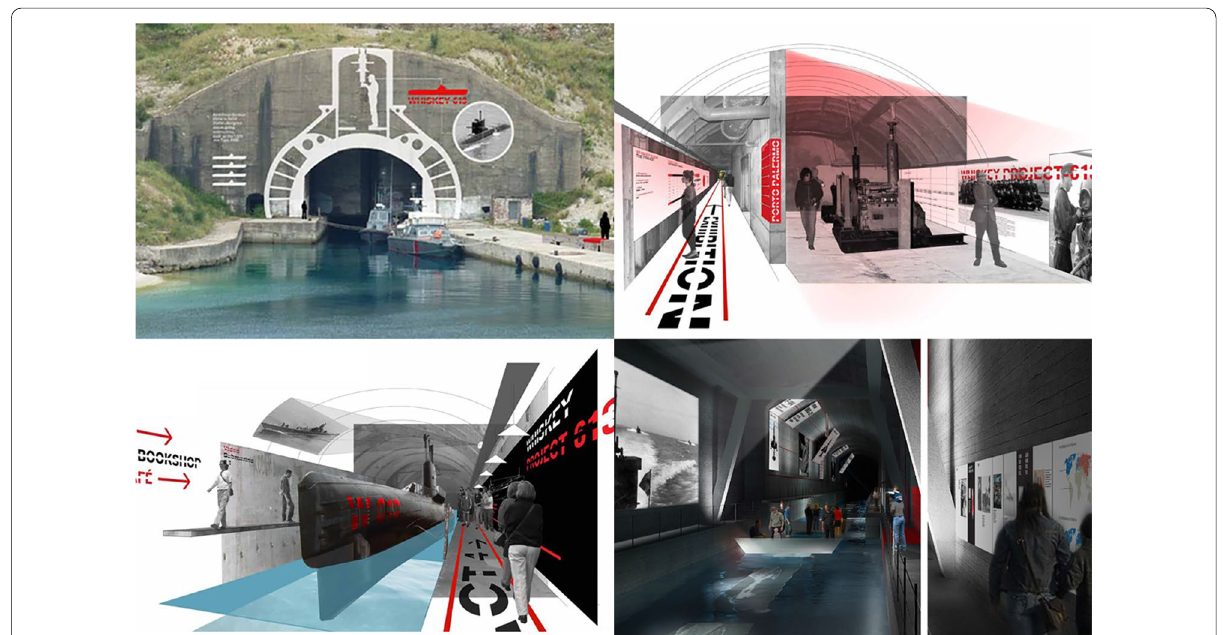
Fig. 16 The interior project of the museum “ The Submarine Tunnel Porto Palermo” , Studio Terragni